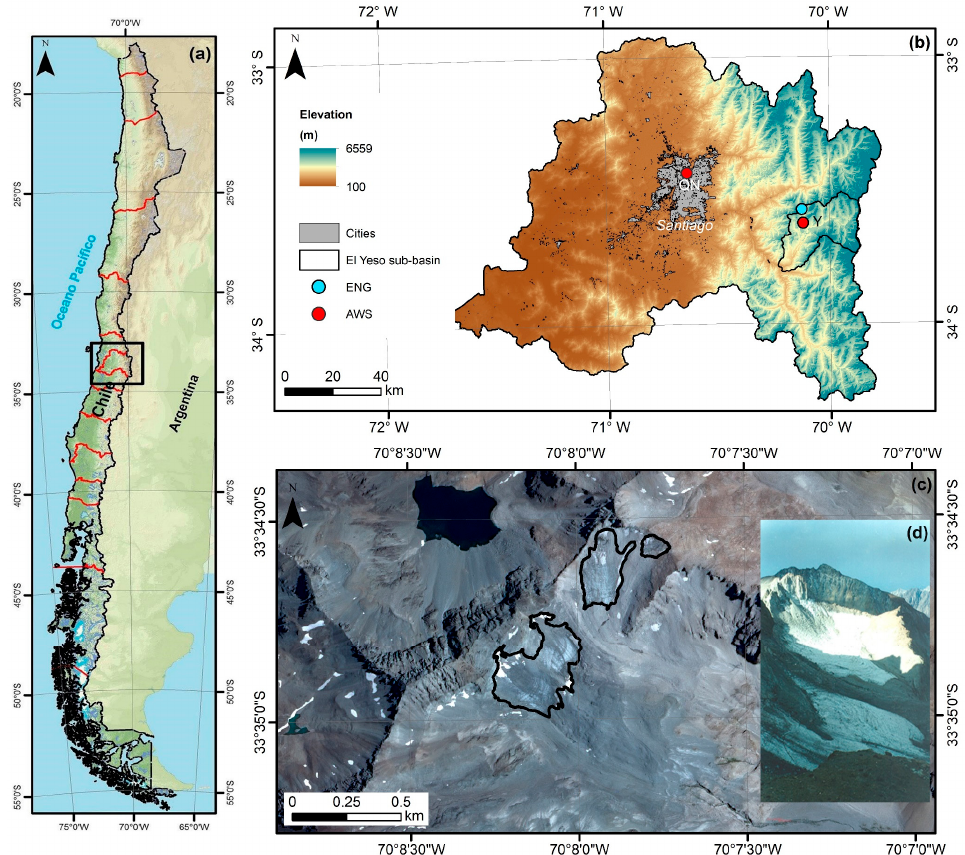
Figure 1. ( a ) Administrative regional distribution of Chile. ( b ) Metropolitan Region, Santiago capital of Chile. El Yeso sub ‐ basin (black line). Background Shuttle Radar Topography Mission (SRTM) digital elevation model (USGS). ( c ) Location of the Echaurren Norte Glacier in the Central Andes of Chile. Glacier area corresponds to 2015. The background is a SPOT satellite image from 30 January 2015 (obtained from the Dirección General de Aguas, DGA). ( d ) Panoramic photography from west to east in March 1999 (Photo taken by Jorge Quinteros, DGA).